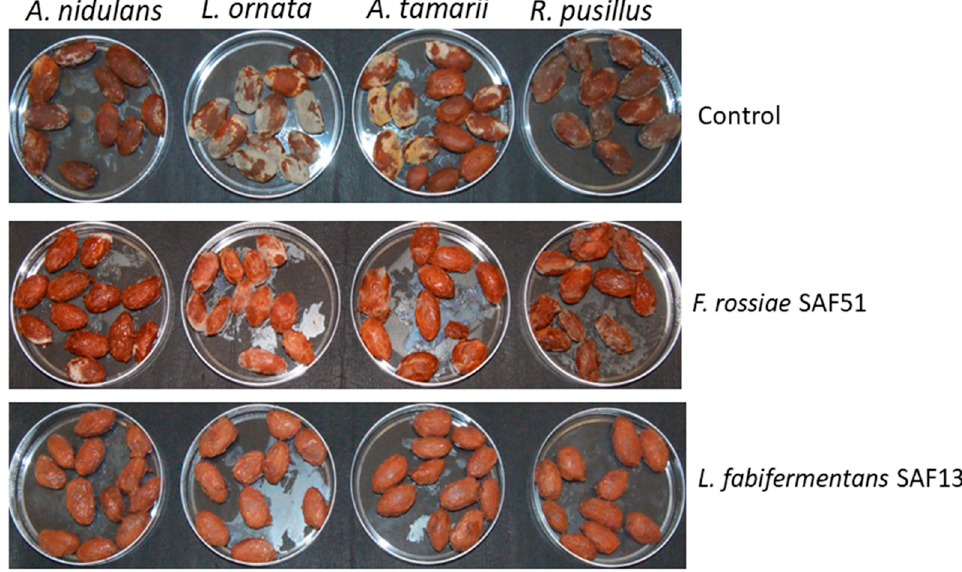
Figure 2. Antifungal activity of strains L. fabifermentans SAF13 and F. rossiae SAF51 against four mould strains isolated from cocoa. Spontaneously fermented cocoa was used as control. Cocoa samples were retrieved at the end of the six-day fermentation period and incubated at 30 °C for three days after inoculum with fungal spores.